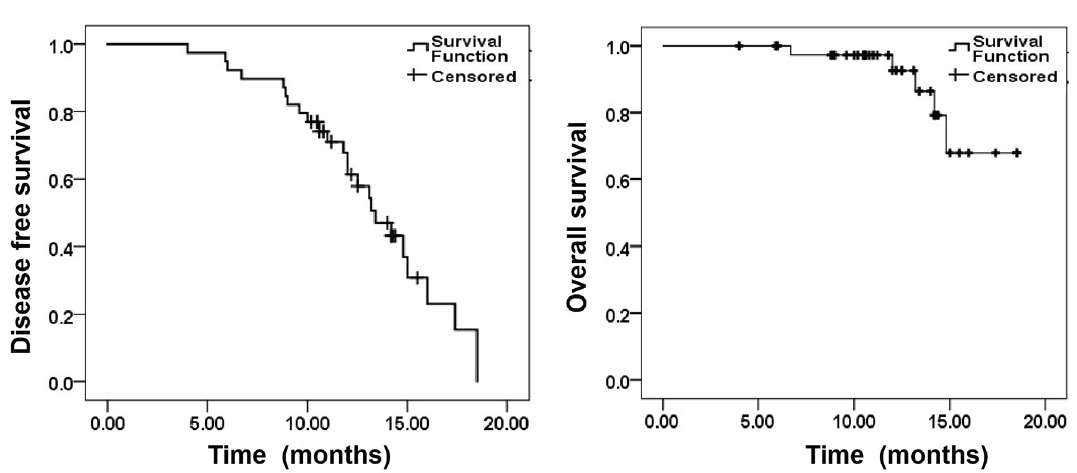
Figure 6. The disease-free survival and overall survival of 39